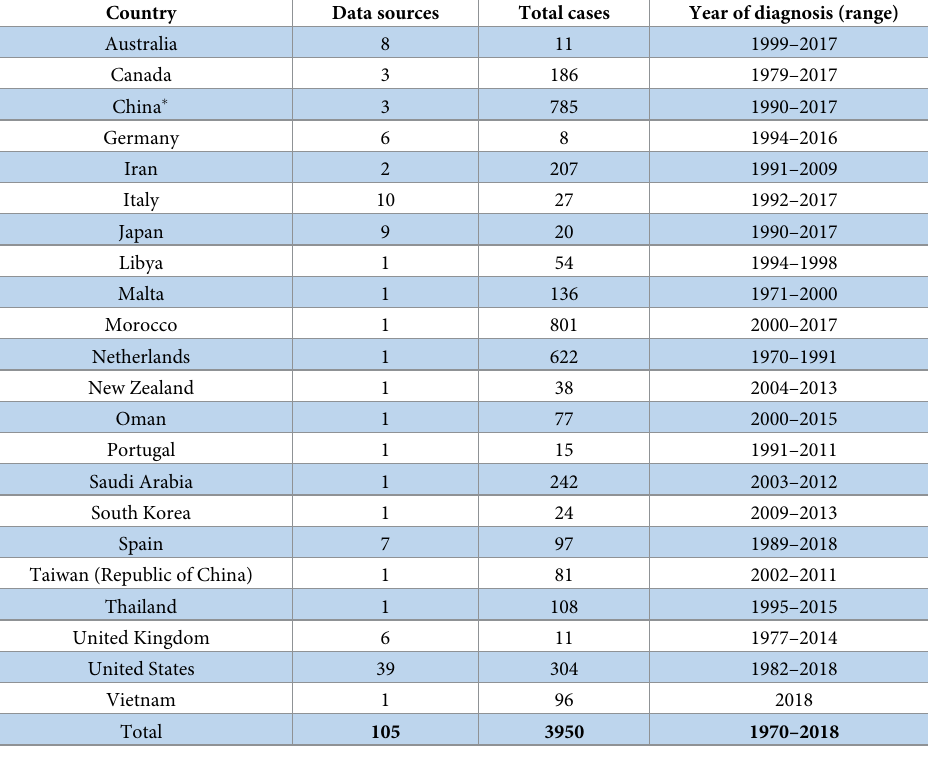
Table 3. Sources of individual leprosy case data from 22 low endemic countries.